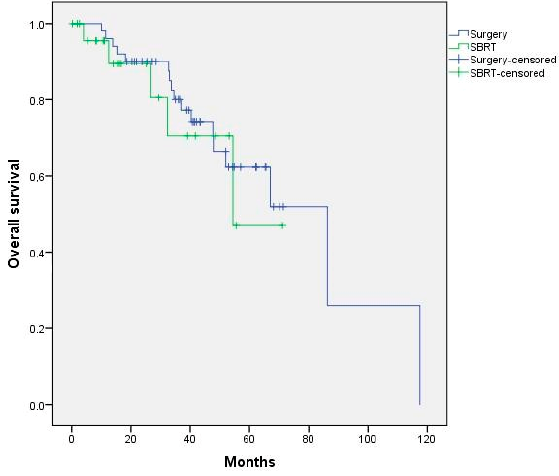
Figure A4. ( a ) Impact of BED on OS; ( b ) impact of BED on L-PFS.